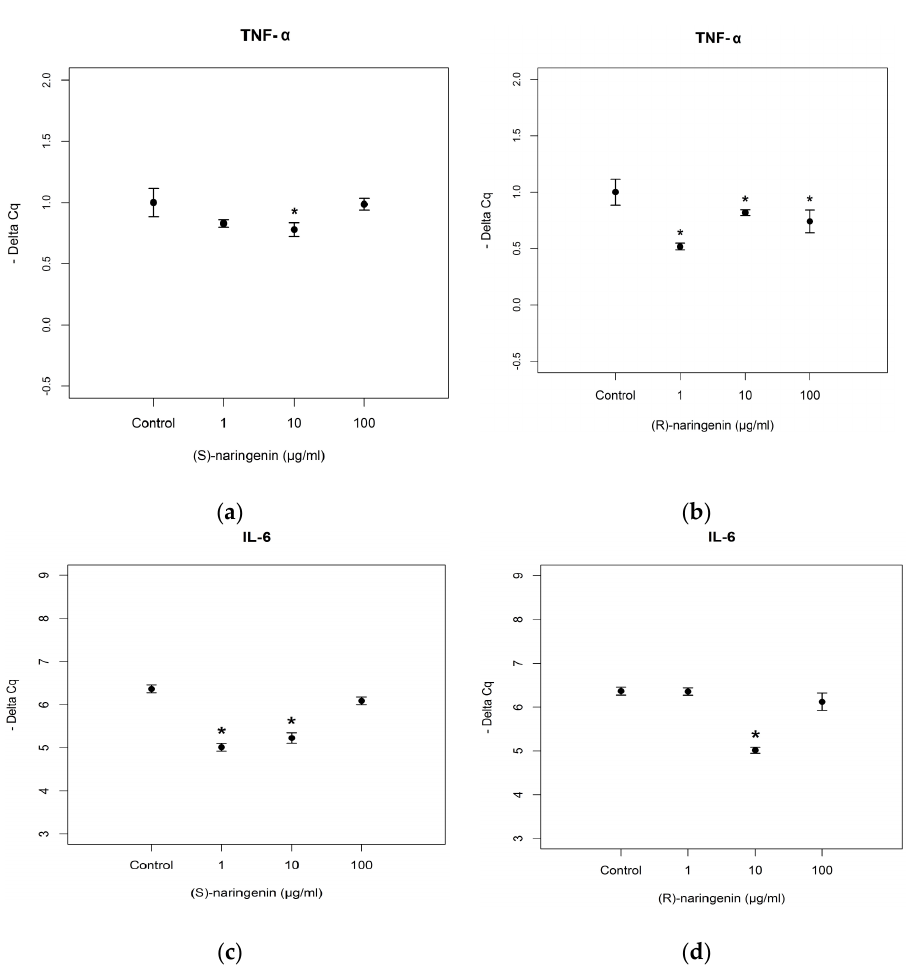
Figure 6. Expression levels, reported as Delta Cq, of mRNA coding for TNF- α in Caco-2 cells treated with increasing concentrations of ( a ) ( S ), and ( b ) ( R ) naringenin enantiomers (1–100 μ g/mL) and and IL-6 in Caco-2 cells treated with increasing concentrations of ( c ) ( S ) and ( d )( R ) naringenin enantiomers (1–100 μ g/mL). * Indicates statistically significant differences between treated and untreated cell cultures, as reported in the text.